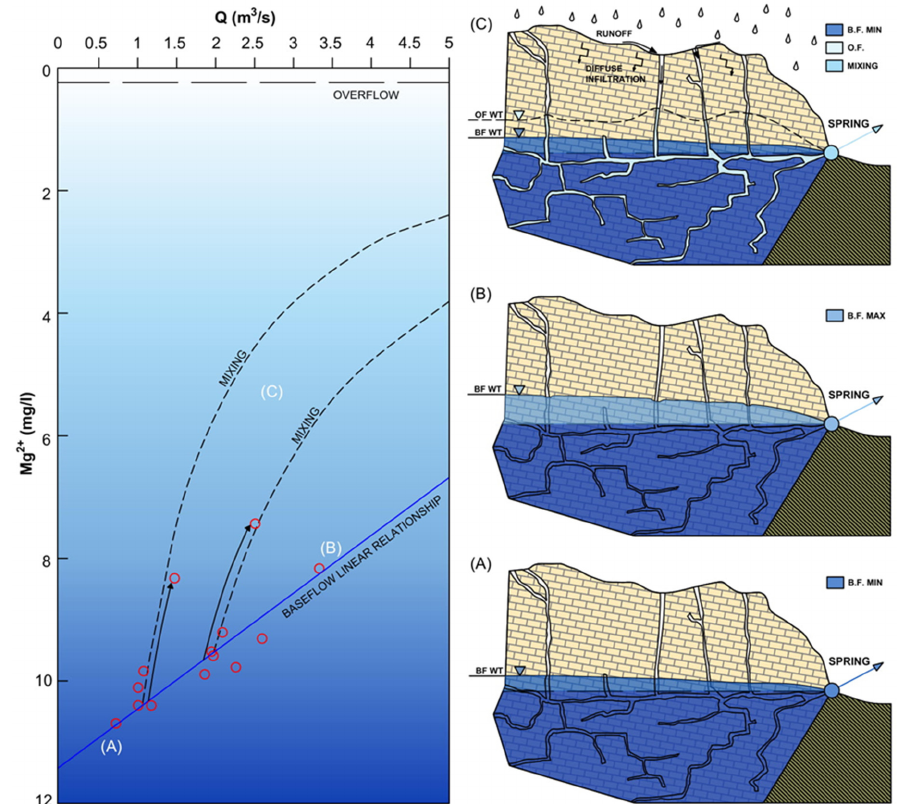
Figure 6. Schematic representation of Pertuso Spring Mg 2+ concentrations and karst aquifer mechanism (modified from Fiorillo et al., 2014 [12]): ( A )—minimum seasonal base flow (B.F.) discharges correspond to higher Mg 2+ contents (dark blue); ( B )—maximum seasonal base flow (B.F.) discharges correspond to lower Mg 2+ contents (blue); ( C )—an intense rainfall event, occurring during seasonal minimum base flow discharges, activates fast overflow (O.F.) coming from conduits network. Groundwater-runoff water mixing leads to an immediate sharp drop in Mg 2+ contents (light blue).